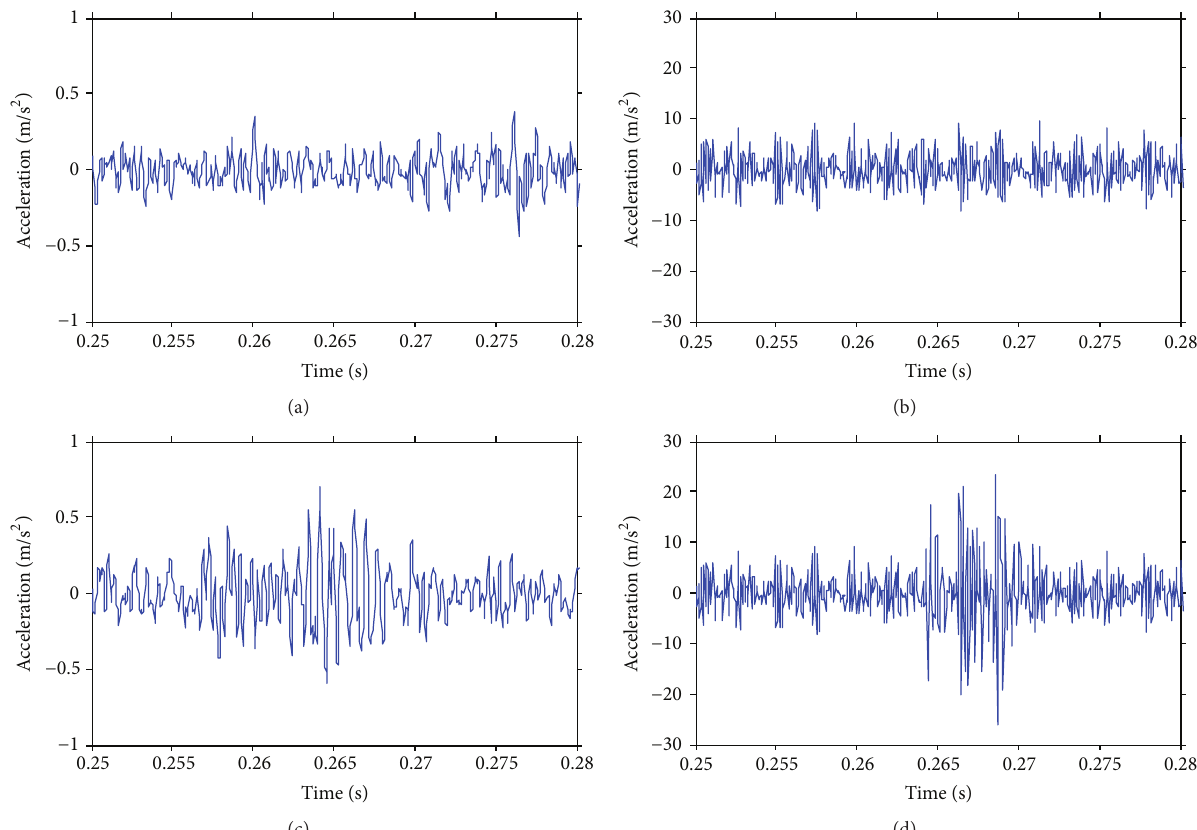
Figure 7: Experimental data and model results for 820 rpm constant speed test: (a) healthy data, (b) healthy model, (c) missing tooth data, and (d) missing tooth